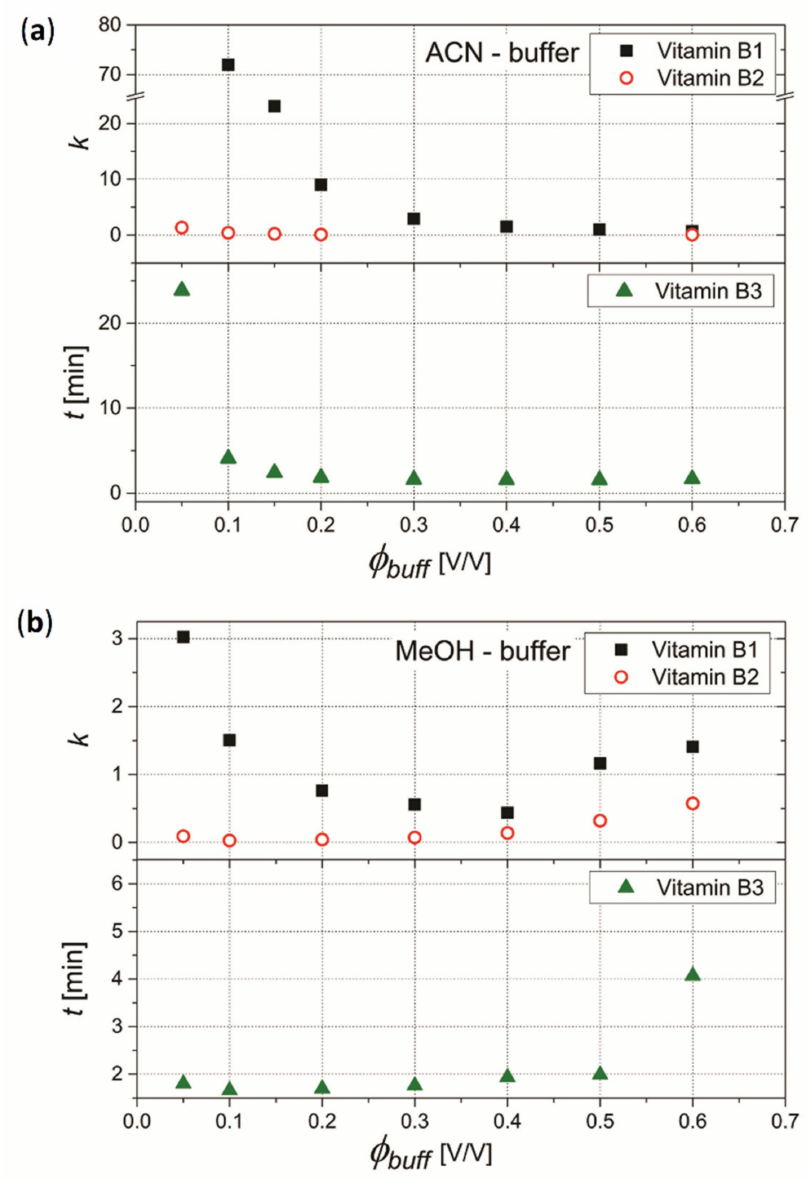
Figure 1. Effects of mobile phase composition ϕ buff on retention coefficient k (or retention time t ) of vitamins obtained using column A (Acclaim™ Mixed–Mode HILIC 1) with: ( a ) acetonitrile and ( b ) methanol as mobile phase